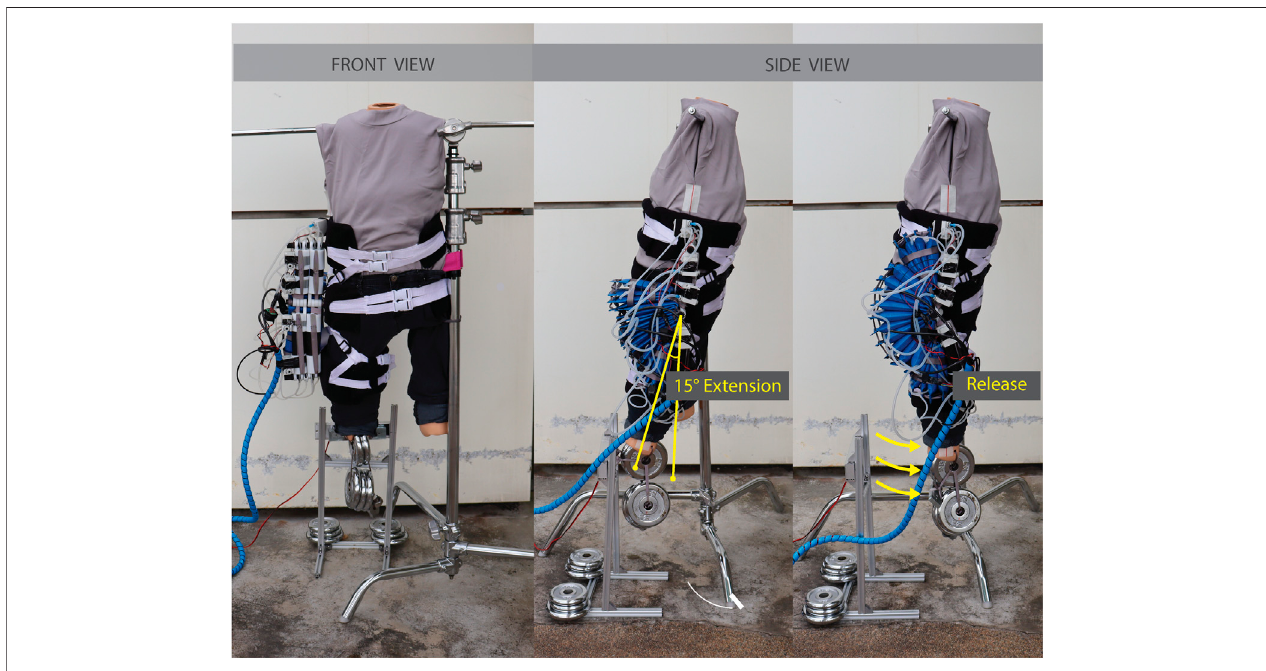
FIGURE 4 | Con fi guration for dynamic pressure test.